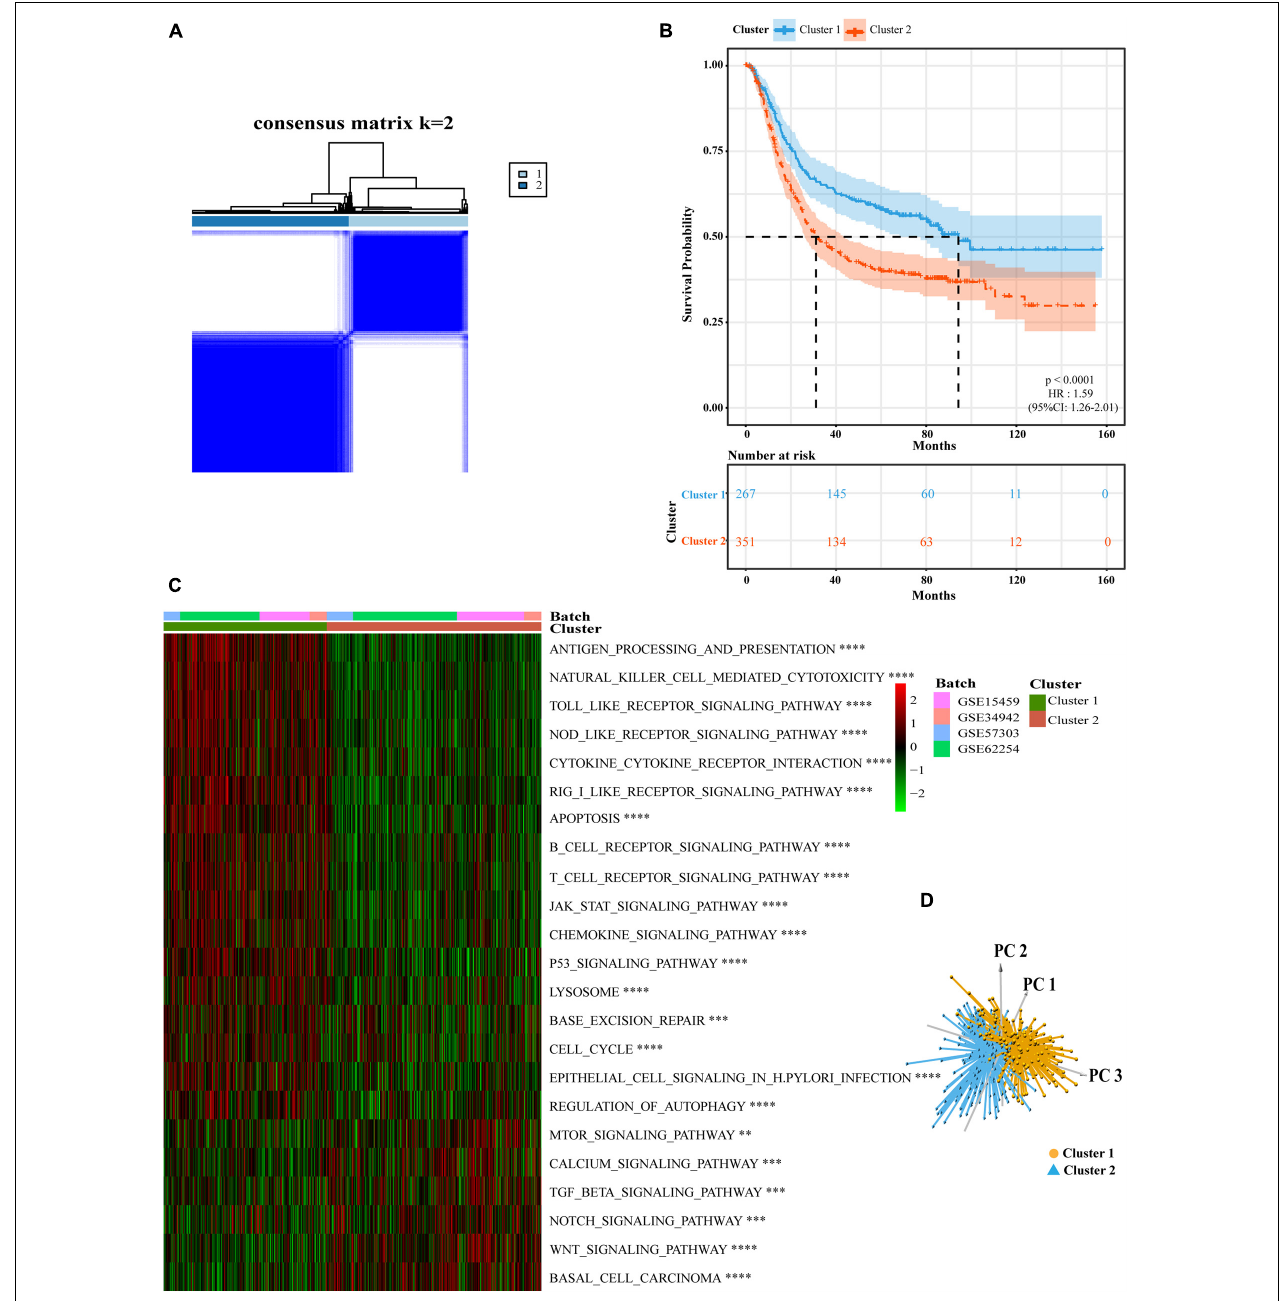
FIGURE 2 | Subgroups of gastric cancer related by pyroptosis-related regulators. (A) The consensus score matrix of all samples when k = 2 in GEO cohorts (GSE15459, GSE34942, GSE57303, and GSE62254). Two samples were more likely to be grouped into the same cluster when there was a higher consensus score between them in different iterations. (B) OS curves for the two pyroptosis-related clusters based on 618 patients with gastric cancer from four GEO cohorts (GSE15459, GSE34942, GSE57303, and GSE62254) (Log-rank test, p < 0.0001). OS, Overall survival. (C) The heatmap was used to visualize biological processes analyzed by GSVA which showed the active biological pathways in distinct pyroptosis-related clusters (Bayes moderation, ∗∗ P < 0.01; ∗∗∗ P < 0.001; ∗∗∗∗ P < 0.0001). (D) Principal component analysis for the expression of pyroptosis-related regulators to distinguish cluster 1 ( n = 267) from cluster 2 ( n = 351) in GEO cohorts (GSE15459, GSE34942, GSE57303, and